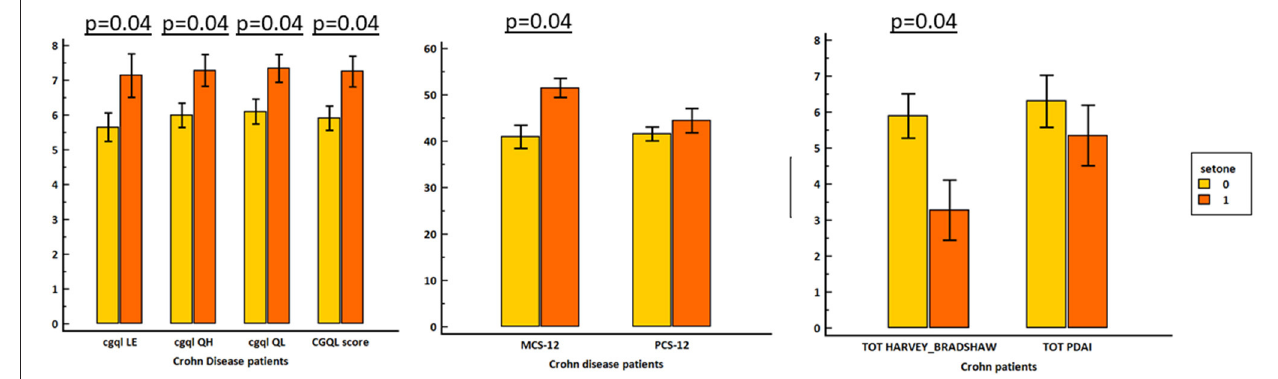
FIGURE 4 | Effect of seton placement on quality of life and disease activity.